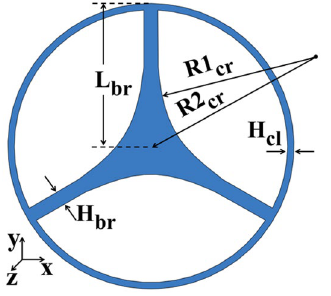
Figure 1. Schematic of the cross-section of a suspended core